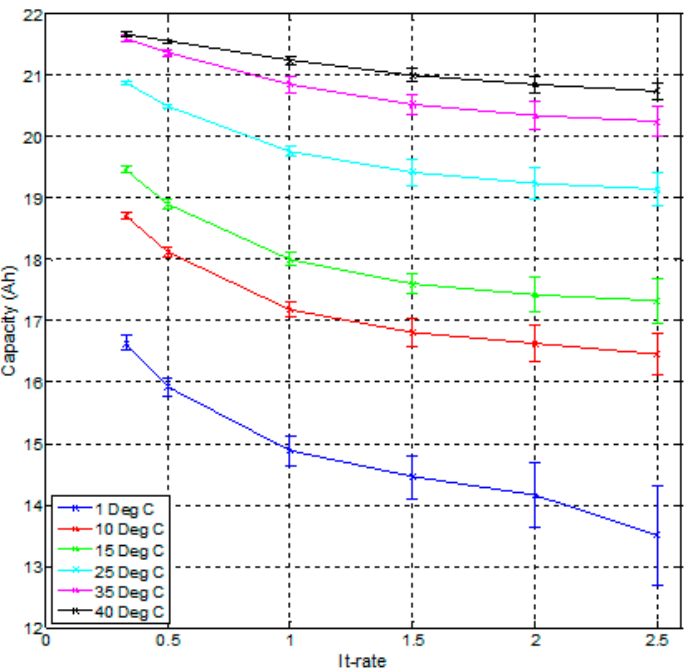
Figure 25. Discharge capacity evolution at different temperatures and different C-rates of NMC 20 Ah lithium ion cells.